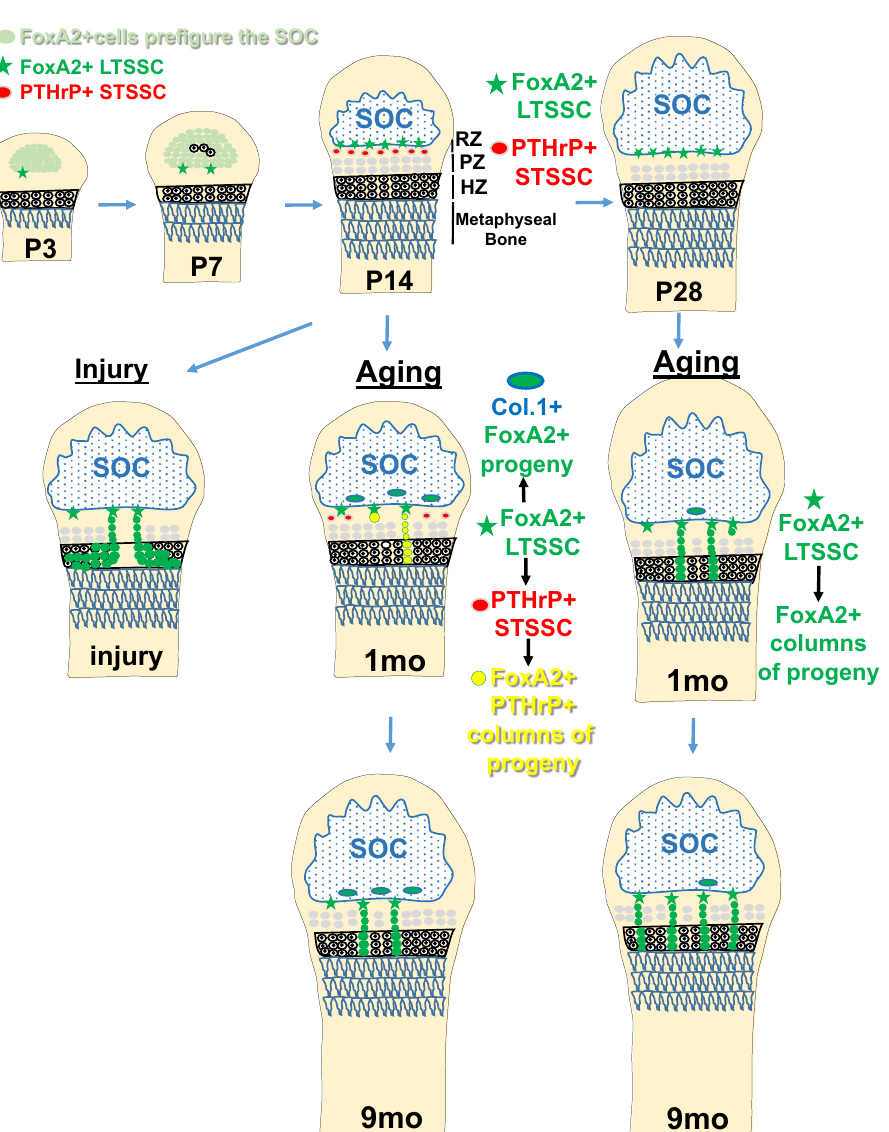
Fig. 9 FoxA2 + LTSSC maintain cartilage homeostasis by contributing to long-term self-renewal, chondrogenic differentiation and cartilage repair after injury. FoxA2 + LTSSC, residual from epiphyseal cartilage postnatal development, located on the outskirts of the SOC, contribute to the top compartment of the RZ. FoxA2 + cells are distinct from the short-term PTHrP + stem cells located at the bottom of the RZ. Prior to P28, FoxA2 + cells have a dual osteo-chondro-progenitor fate, contributing to the chondrogenic lineage (by forming columnar stacks of chondrocytes in the GP), and the osteogenic lineage (by forming col.1 + bone cells in the SOC). After P28, FoxA2 + LTSSC remain mostly in GP, and their contribution to the SOC is reduced. GP injury activates FoxA2 + cells to undergo proliferative expansion and to provide a framework for the regenerating tissue. In conclusion, FoxA2 + cells, located in the top compartment of the RZ, are a PTHrP-(negative) long-term skeletal stem cell (LT-SSC) population necessary for both GP turnover and cartilage regeneration following injury. SOC = secondary ossi fi cation center, RZ = resting zone, PZ = proliferating zone, HZ = hypertrophic